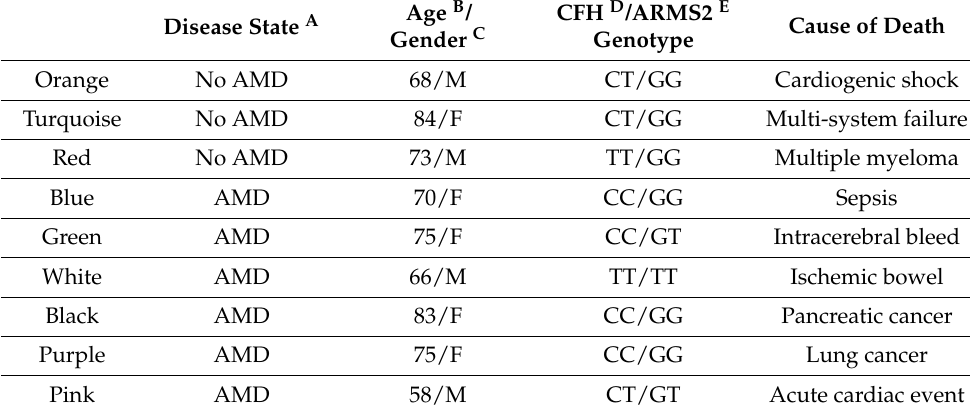
Table 1. Demographics of donors—haRPE and iPSC-RPE matched pairs.